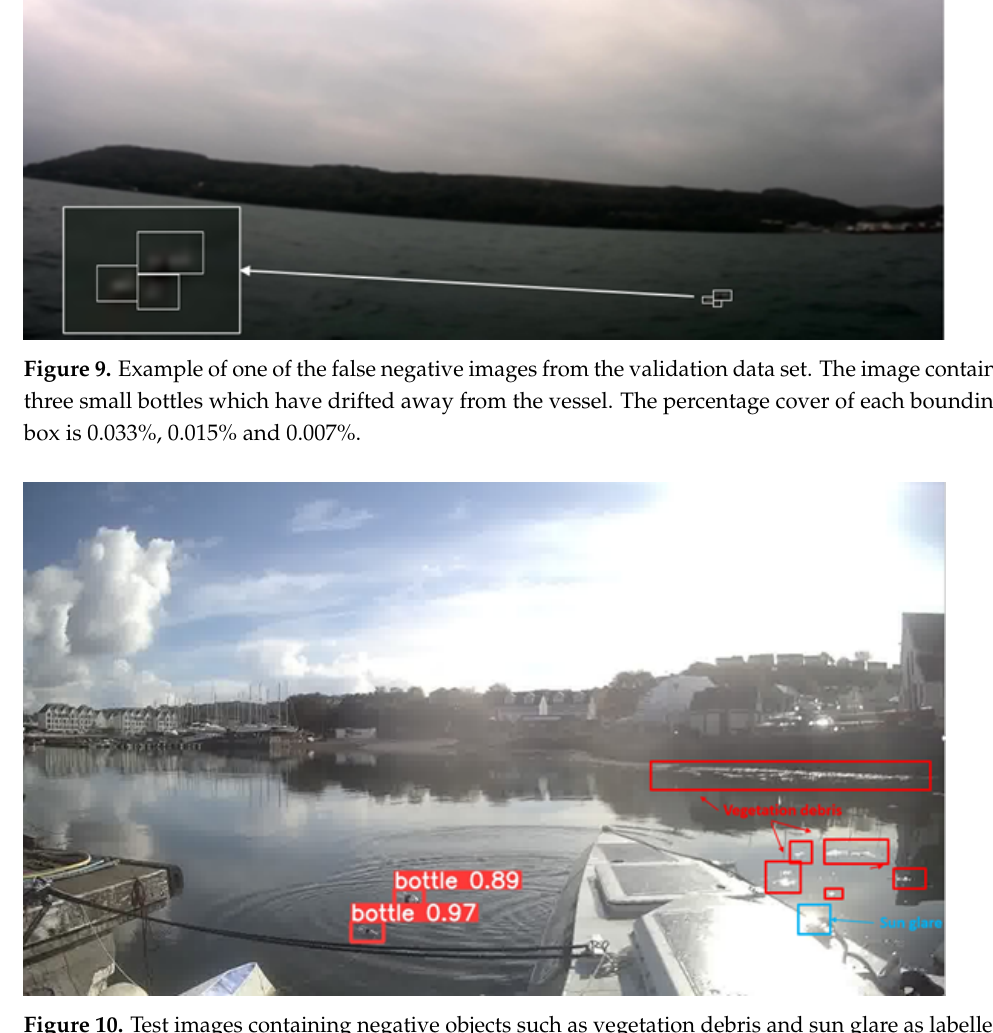
Figure 10. Test images containing negative objects such as vegetation debris and sun glare as labelled on the image. The model ignored these objects and detected the three plastic bottles as shown in the